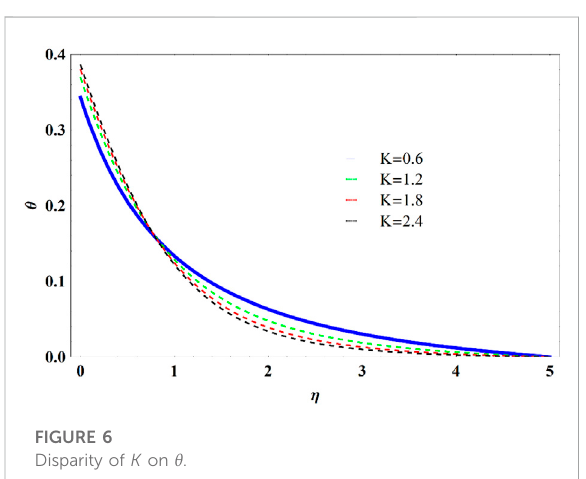
FIGURE 6 Disparity of K on θ .